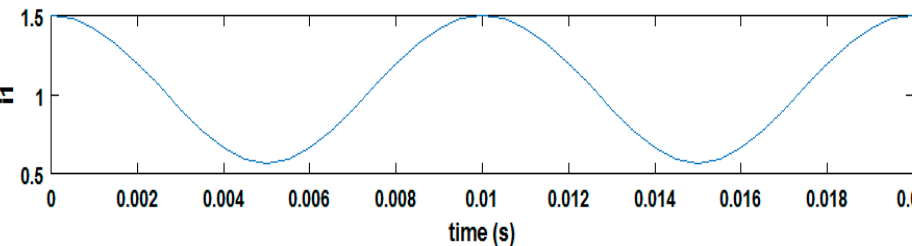
Figure A3. Leg current—proposed method.